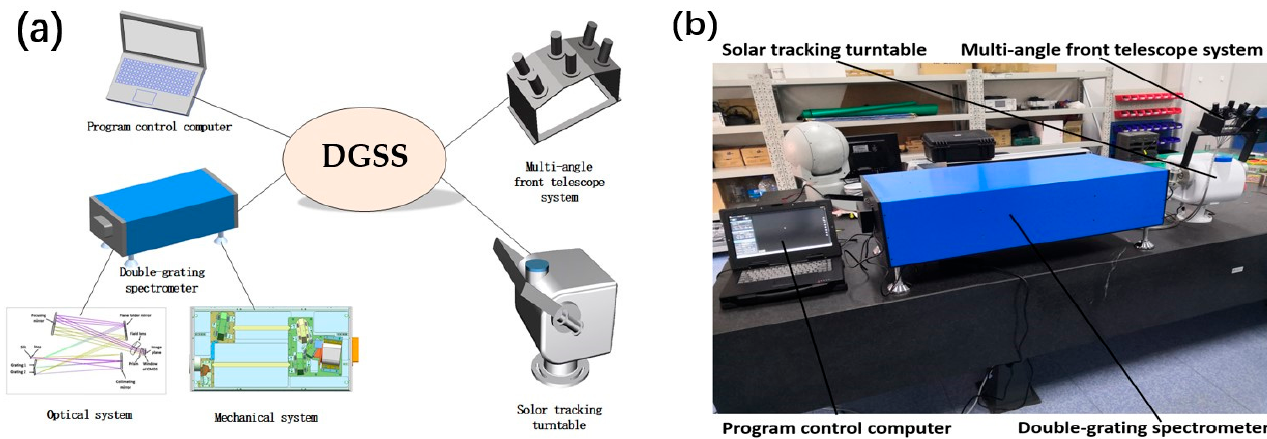
Figure 4. The components of DGSS: ( a ) Schematic diagram; ( b ) Physical diagram.